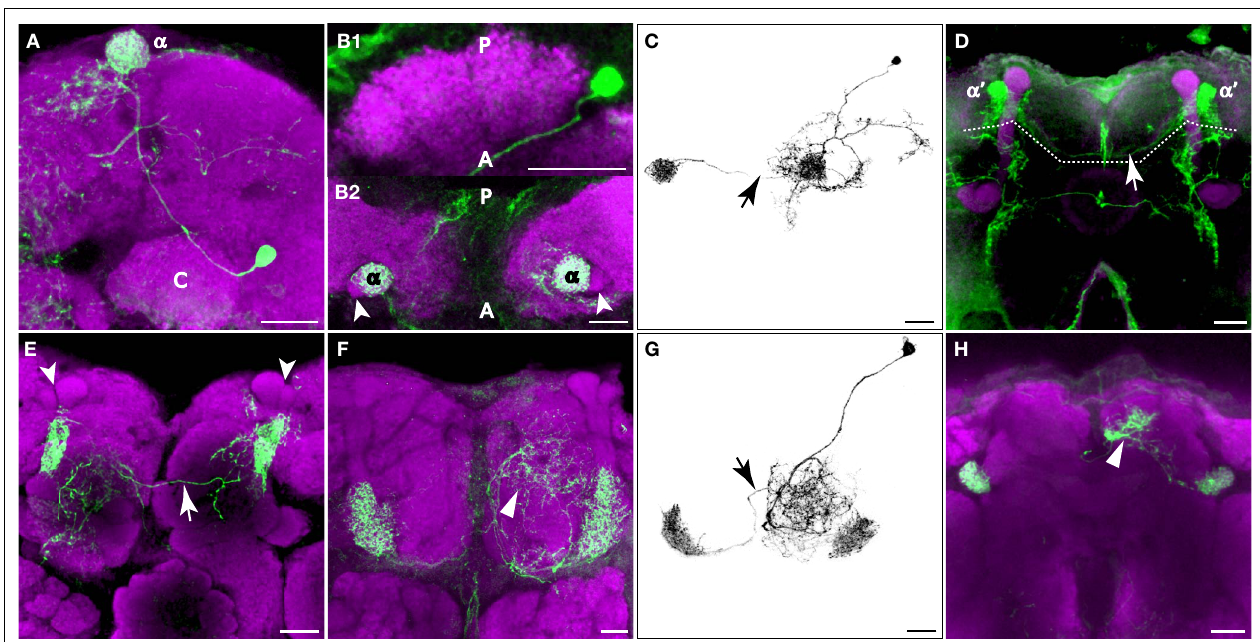
FIGURE 5 | PPL1 neurons innervate distinct areas of the mushroom body lobes. Green, anti-GFP from TH-GAL4 fl ip-out clones. Magenta, anti-FasII immunostaining in panel (D) , anti-nc82 immunostaining in all others. Grayscale, GFP signal with background removed along with other unrelated structures. Scale bar in all panels: 20 µm. (A) One type of PPL1 neuron innervates the tip of the α lobe. Posterior view. Medial is to the left; lateral to the right. The cell body is located lateral to the calyx (C). (B1,B2) Dorsal view of another PPL1 neuron. Posterior (P) is up; anterior (A) is down. (B1) Cell body is located lateral to the calyx. The primary process runs along the anterior margin of the calyx rather than entering it. There was no indication at this level of resolution that the calyx is innervated by PPL1 neurons. (B2) The tips of the α lobes ( α ), but not the α′ lobes (arrowheads), are innervated bilaterally by the PPL1 neuron cell body shown in (B1) . (C) The entire track of the neuron in panels (B1) and (B2) viewed from a dorsal perspective. Arrow points to the fi ber providing innervation to the contralateral α lobe tip. There is considerable branching of the neuron in the dorsal ipsilateral protocerebrum prior to contacting the ipsilateral α lobe. (D) One type of PPL1 neuron bilaterally innervates the tip of α′ lobe. Robust innervation of the tip of the α′ lobe is observable in this PPL1 clone. The arrow points to the fi ber connecting the two hemispheres. Only the processes innervating the α′ lobe tip are